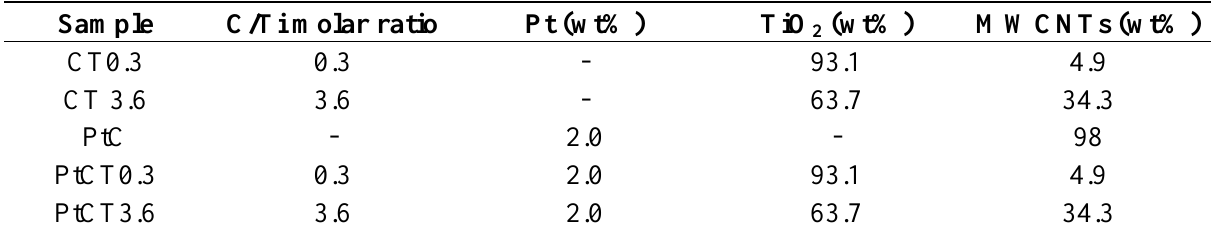
Table 1. Chemical composition of the investigated